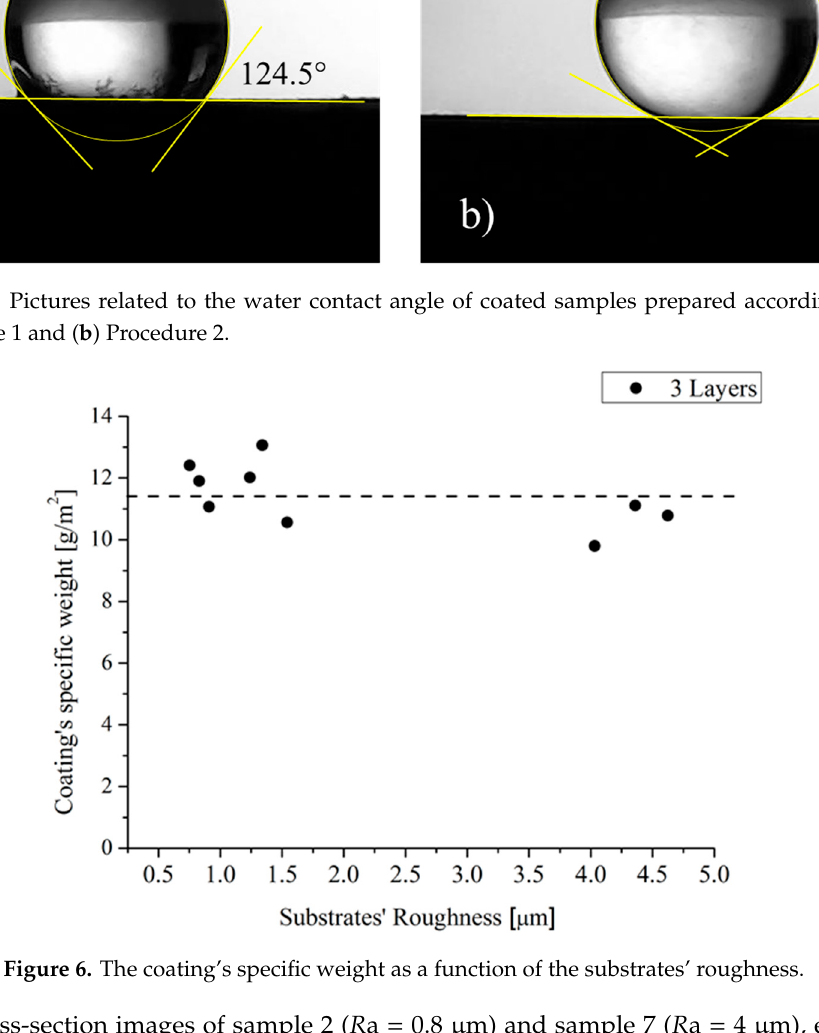
Figure 6. The coating’s specific weight as a function of the substrates’ roughness.